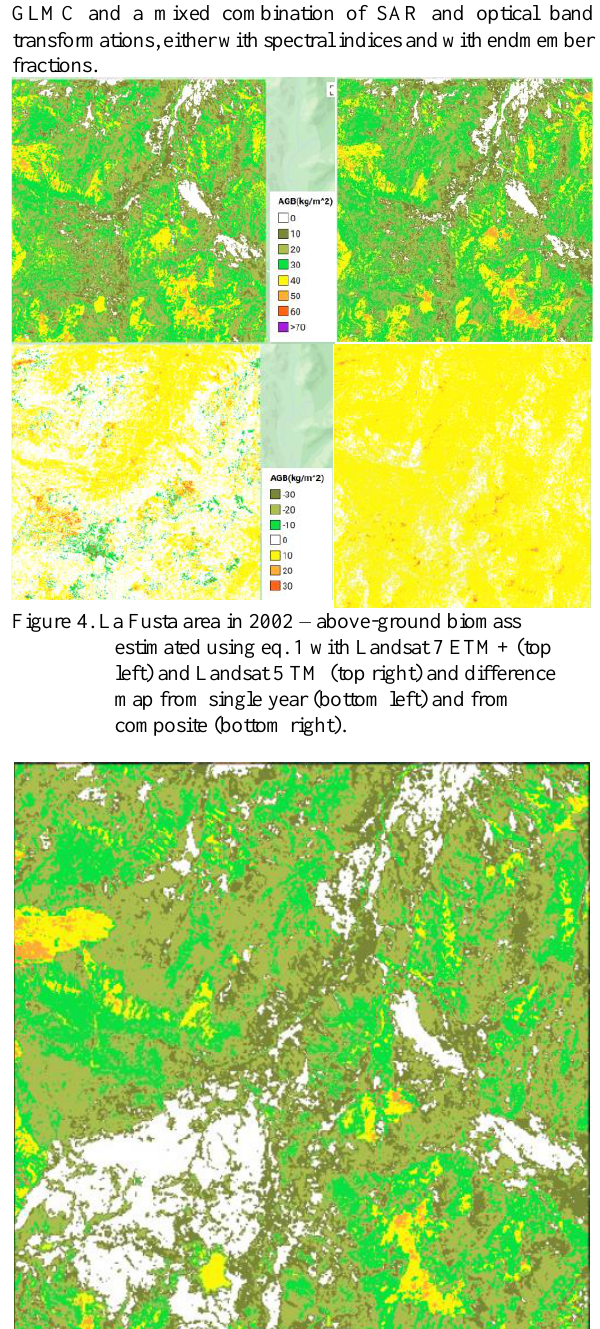
Figure 5. Model from eq. 1 applied using Landsat-8 and PALSAR/PALSAR-2 – area without vegetation at bottom left is in-line with lost vegetation checked with global forest change in (Hansen et al.,